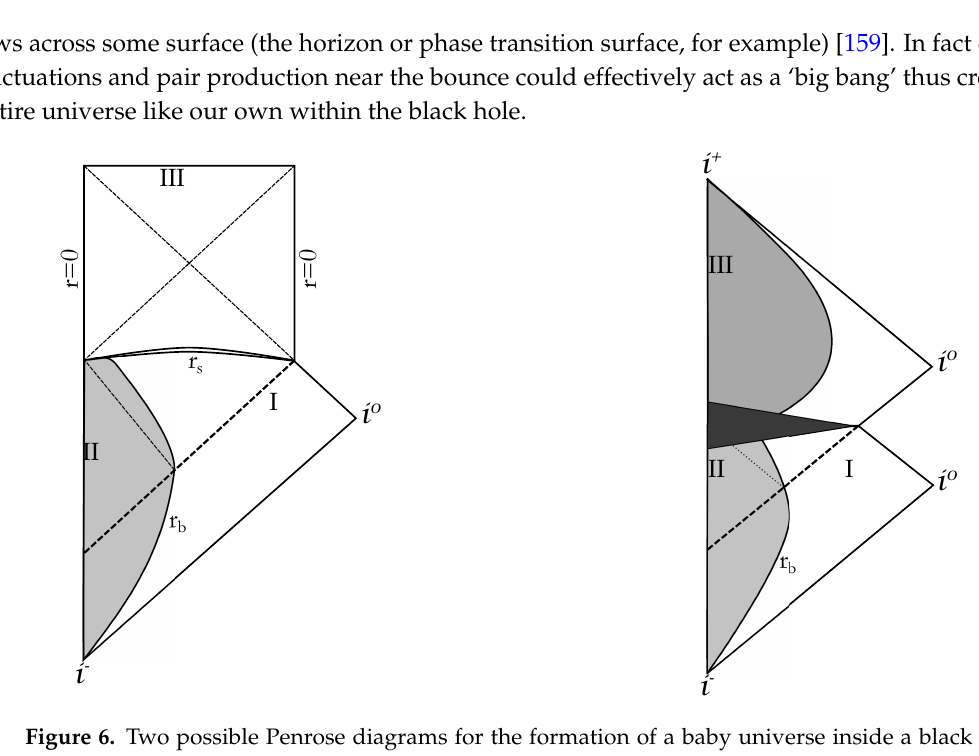
Figure 6. Two possible Penrose diagrams for the formation of a baby universe inside a black hole. Collapse of a matter cloud (grey region II within boundary r b ) proceeds classically until after the formation of the event horizon (thick dashed line). The event horizon in not affected by quantum corrections close to the singularity. Far away observers (in region I) see the formation of a Schwarzschild black hole. Left panel : The singularity at the end of collapse is removed and replaced by a junction surface (double solid line r s ) to a DeSitter universe (region III). The thin dashed lines represent the Cauchy horizons (see [150]). Right panel : When reaching the quantum gravity region (darker grey region) matter undergoes a phase transition and re-expands after the bounce (region III).